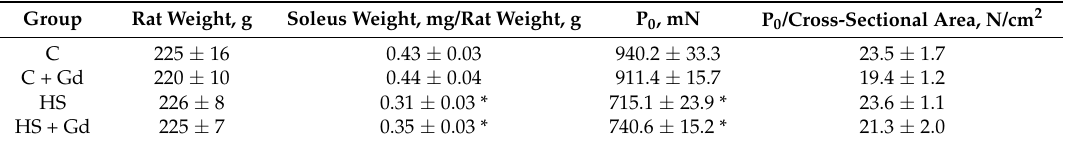
Table 2. Changes in rat’s body weight, soleus weight-to-body weight ratio and P 0 , and P 0 normalized to muscle cross-sectional area following 7 days of hindlimb unloading (experiment 2).